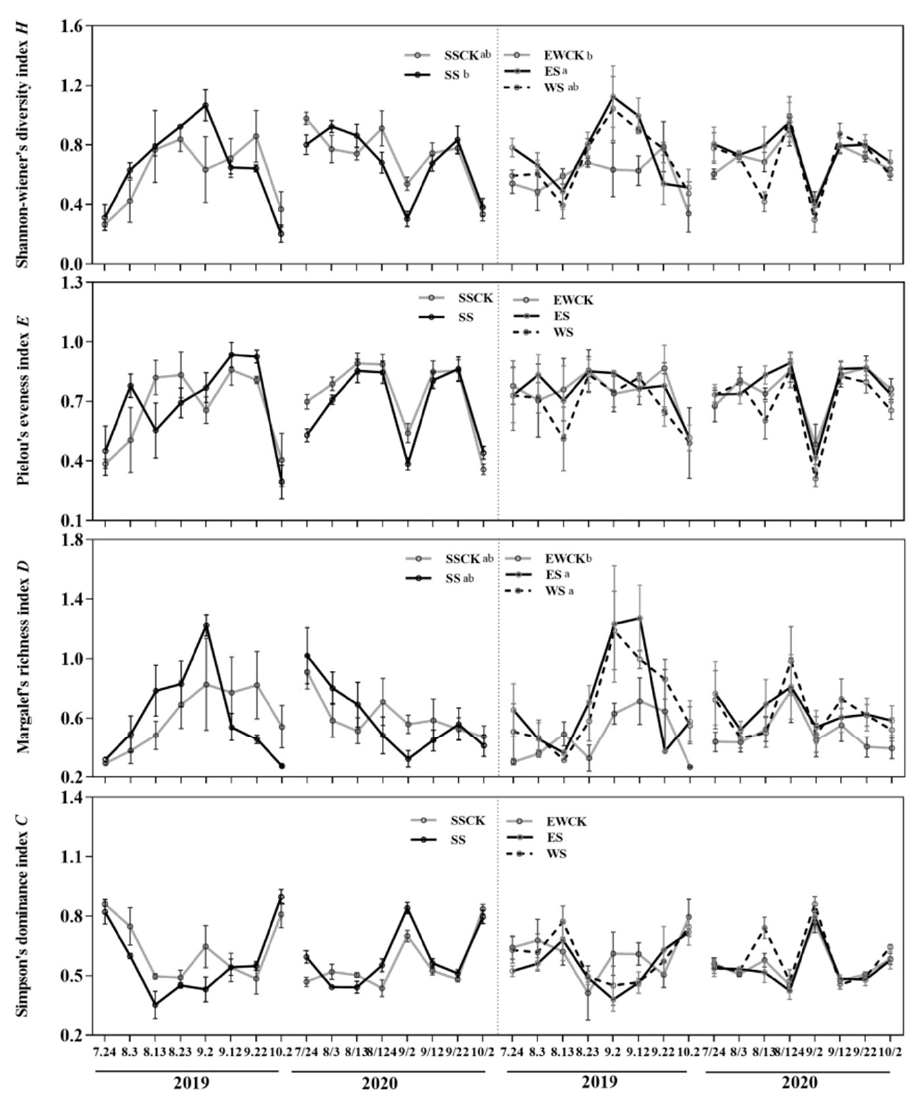
Figure 6. Community diversity indexes of the collected insects under the intercropped maize ecological shading in tea plantation.